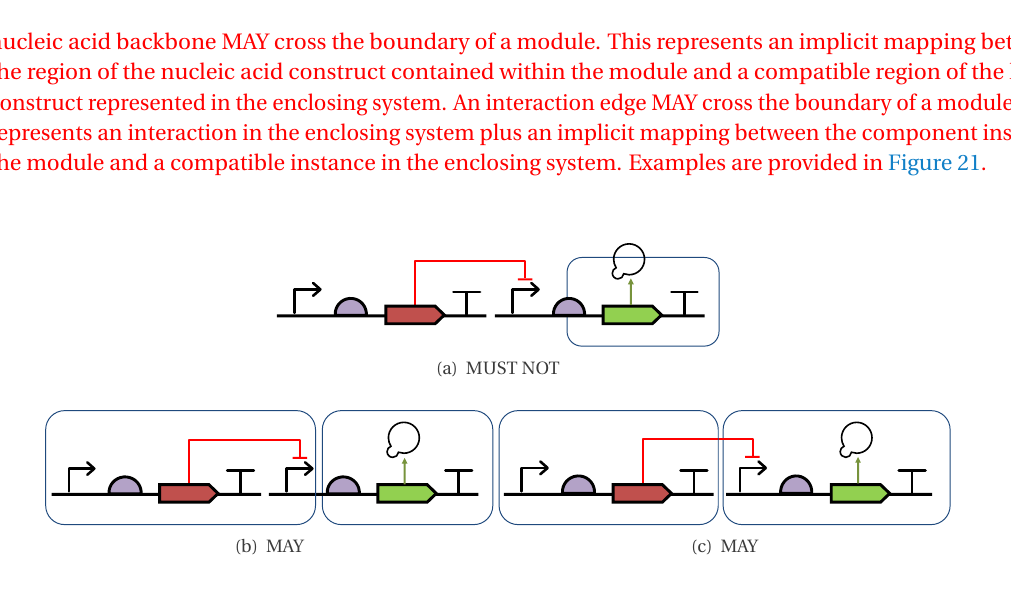
Figure 21: Examples of recommended and problematic boundary intersections: (a) sequence feature and molecular species glyphs MUST NOT intersect a module boundary, (b) implicit mapping from the promoter in the left module and the regulated elements in the right module to a nucleic acid construct ordering both into a complete functional unit, (c) implicit mapping from the CDS in the left module and the promoter in the right module to instances in the complete system in which the CDS inhibits the promoter (presumably by a repressor